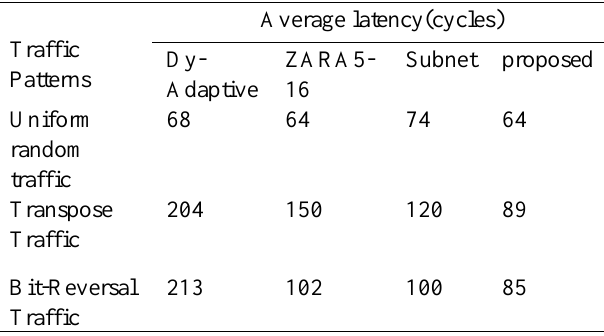
Average latency of proposed algorithm in comparison with others under various injection rate: